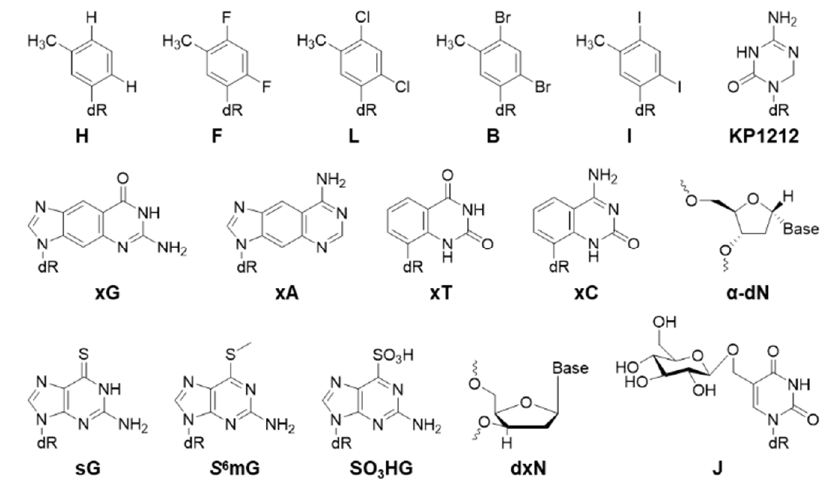
Figure 4. Structures of bulky and crosslinked lesions.